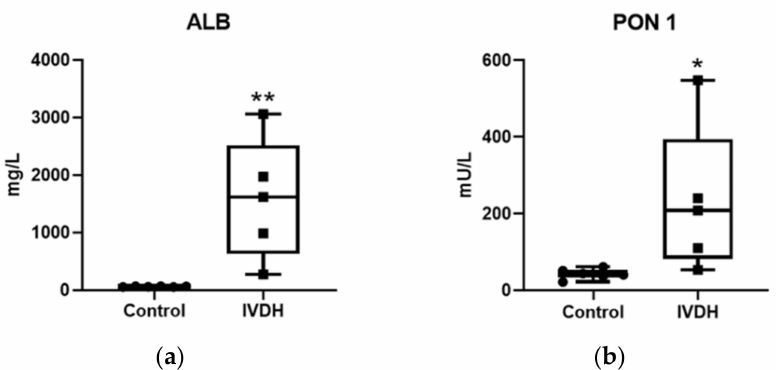
Figure 3. Analytical validation of proteomic results: ( a ) measured activity of paraoxonase 1 (PON1), ( b ) albumin (ALB) concentration in cerebrospinal fluid of intervertebral disc herniation (IVDH) group compared to the control group. * p < 0.05 ( p = 0.0375 herein), ** p < 0.01 ( p = 0.0058